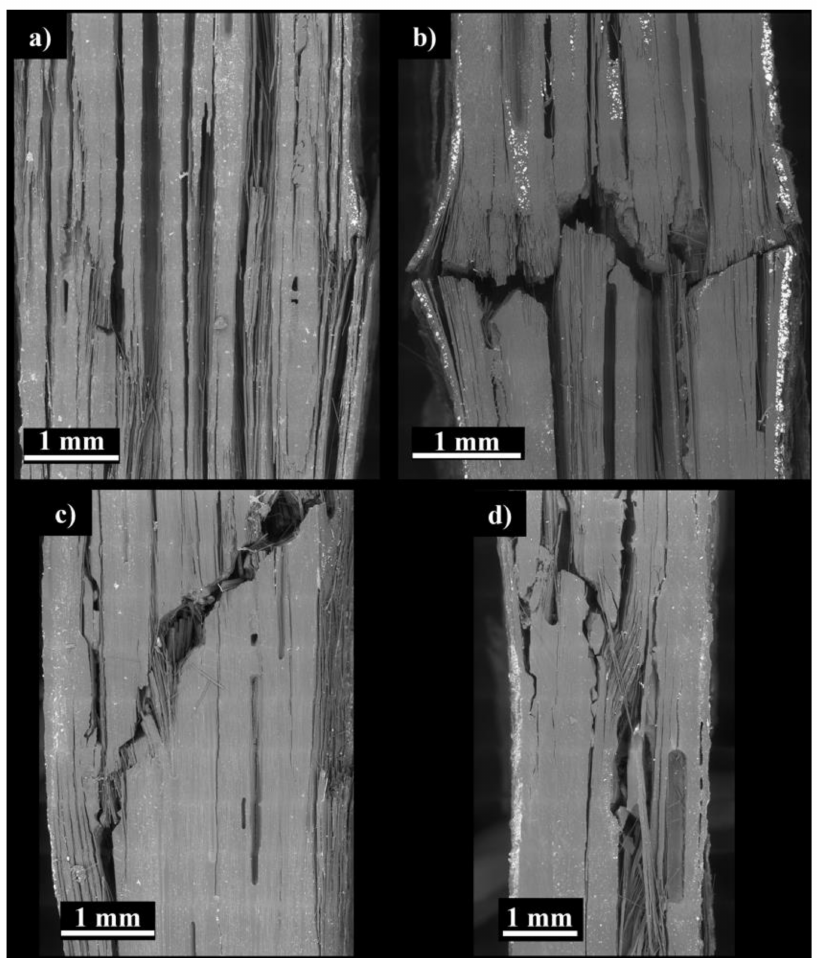
Figure 7. SEM images of the gage section of UD composites after compression testing under different environmental temperatures: ( a ) room temperature, ( b ) 100 ◦ C, ( c ) 200 ◦ C, and ( d ) 300 ◦